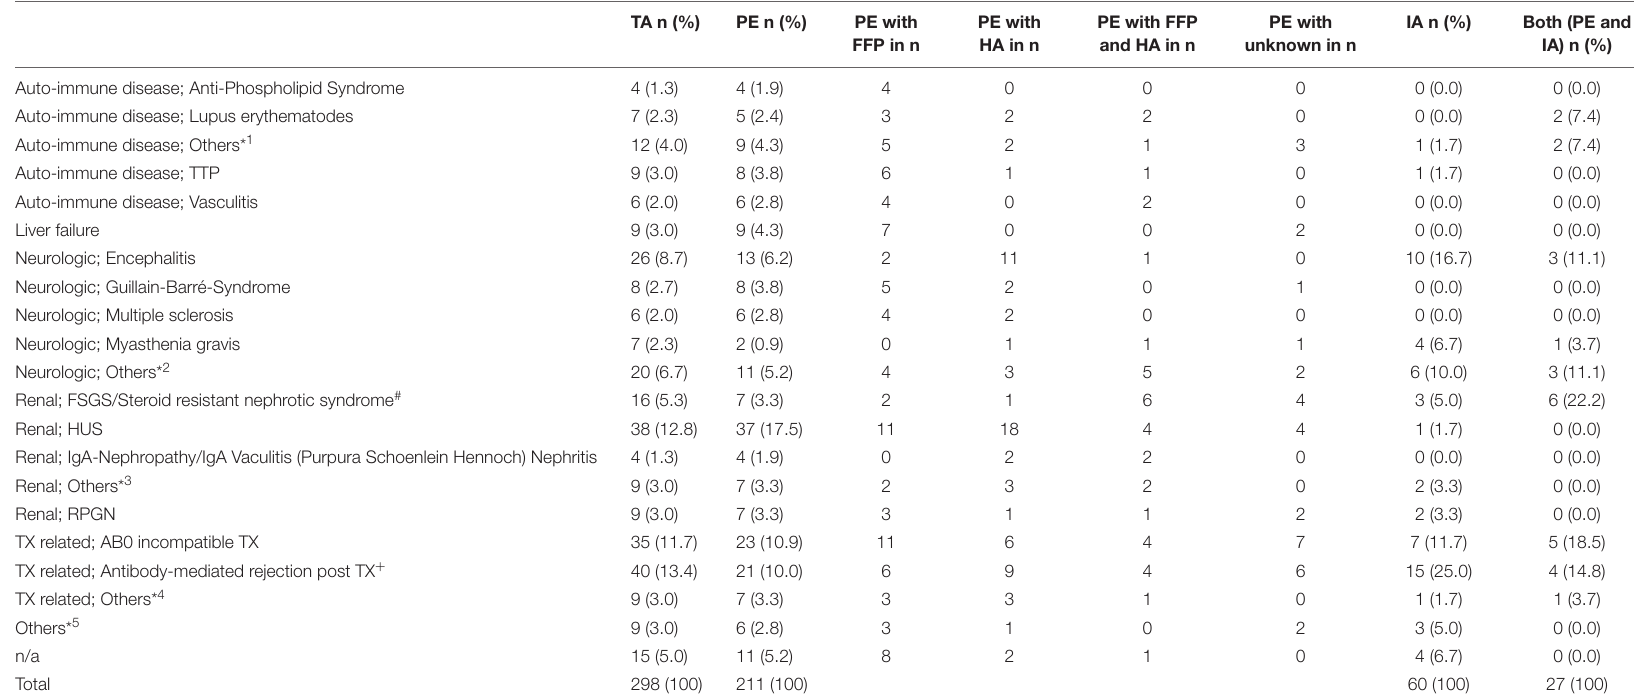
TABLE 2 | Underlying disease per